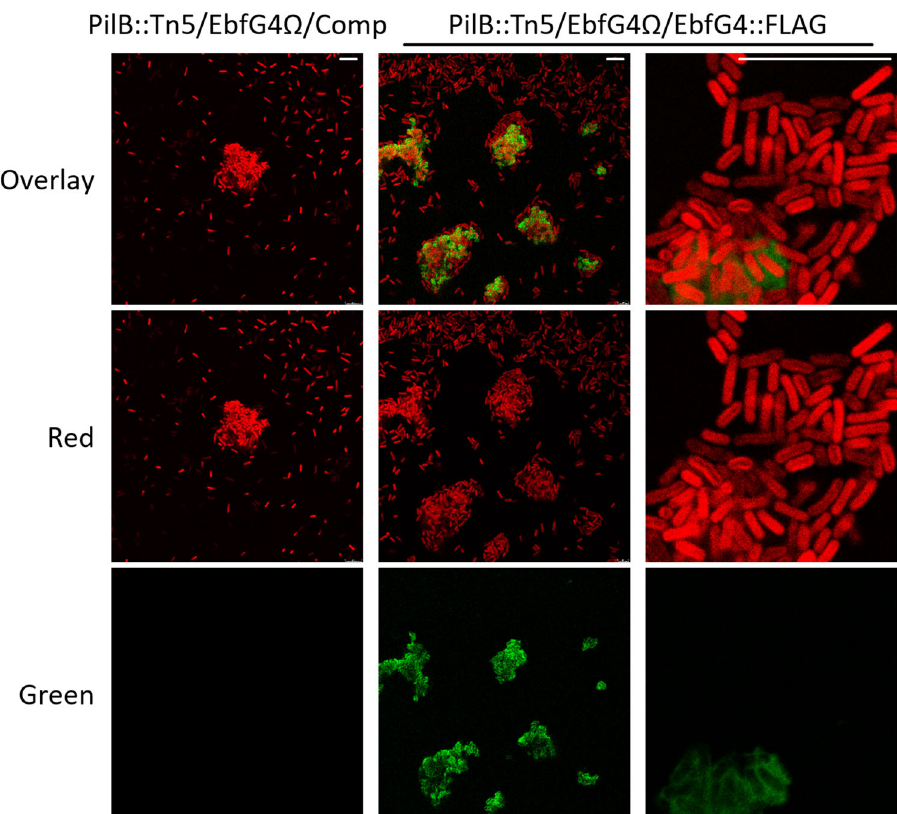
Fig. 5 Visualization of EbfG4::FLAG in permeabilized cells by immunocytochemistry and confocal fl uorescence microscopy. Strains analyzed: PilB::Tn5/EbfG4 Ω /Comp and PilB::Tn5/EbfG4 Ω /EbfG4::FLAG. Red represents auto fl uorescence whereas green indicates presence of EbfG4::FLAG. The scale bars correspond to 10